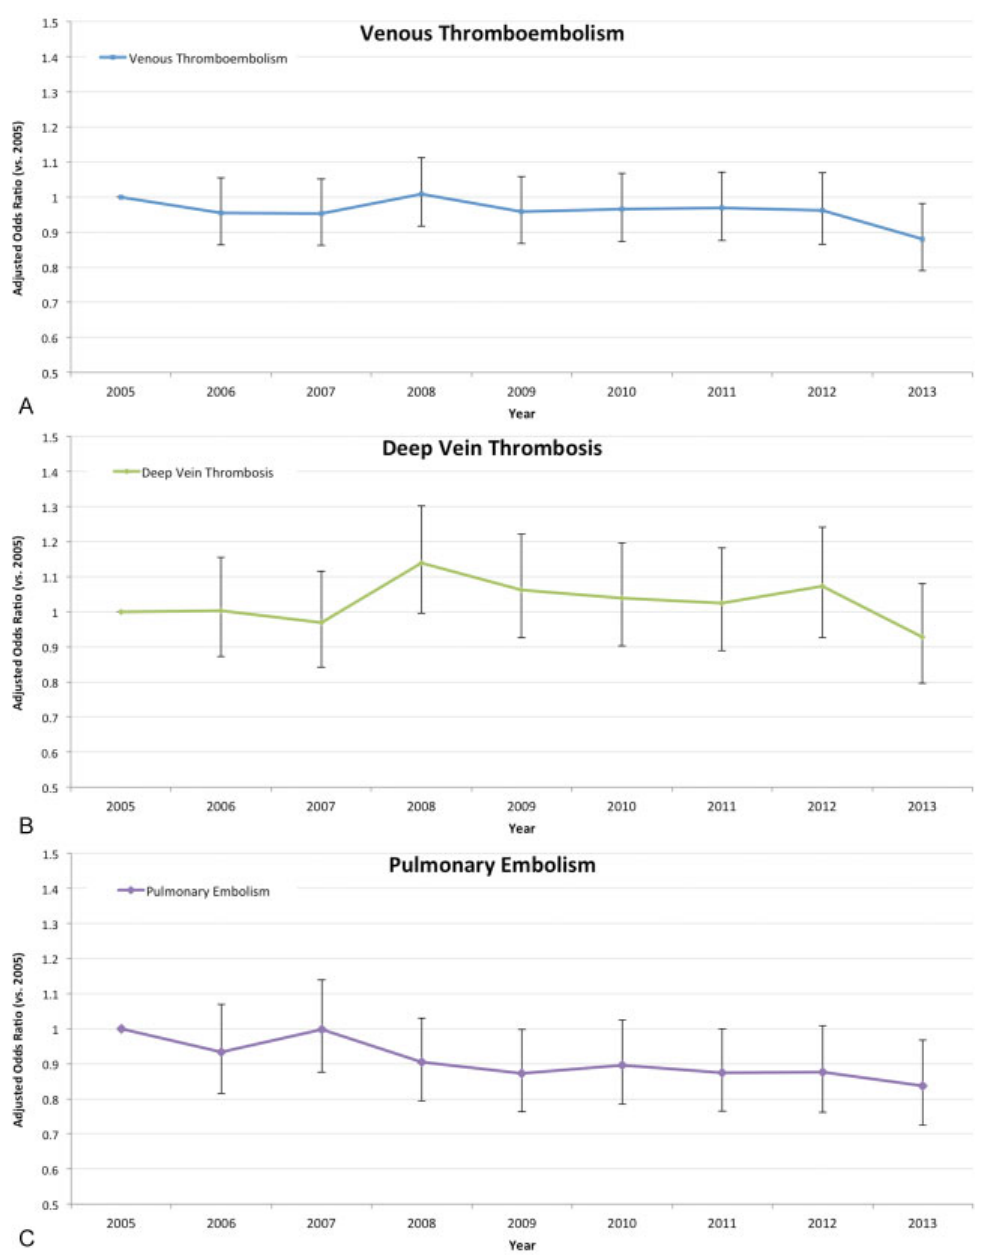
Fig.4 Adjustedoddsratio(OR)forin-hospitalmortalityassociatedwithvenousthromboembolism( A ),deepveinthrombosis( B ),andpulmonaryembolism ( C )afternoncardiacsurgery,accordingtoyear.Modelswereadjustedforpatientdemographiccharacteristics,cardiovascularrisk factors,andsurgicaltype. Adjusted ORs are calculated with 2005 as the reference year. Bars represent 95% con fi dence